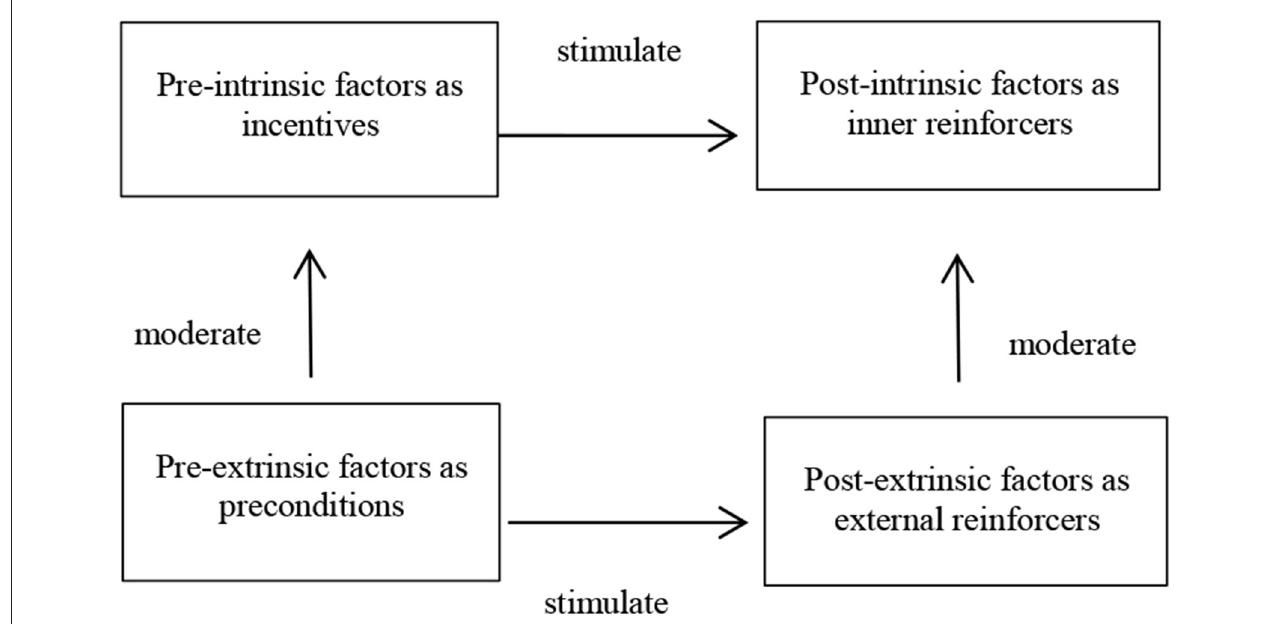
FIGURE 1 | Theoretical model for the motivation factors of pursuing an Ed.D in the Chinese context.